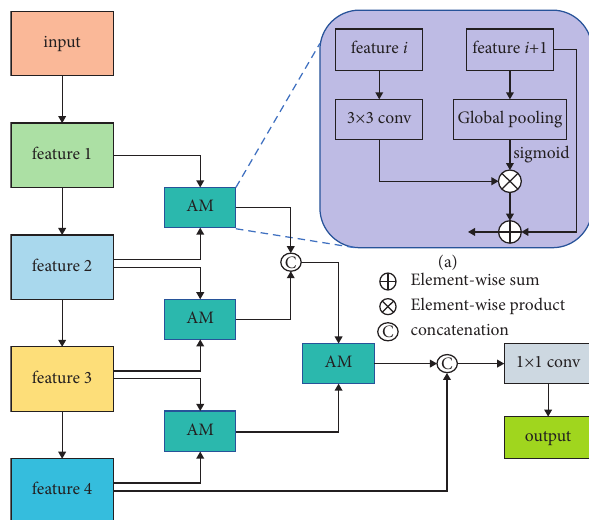
Figure 5: Structure of PML-RFE